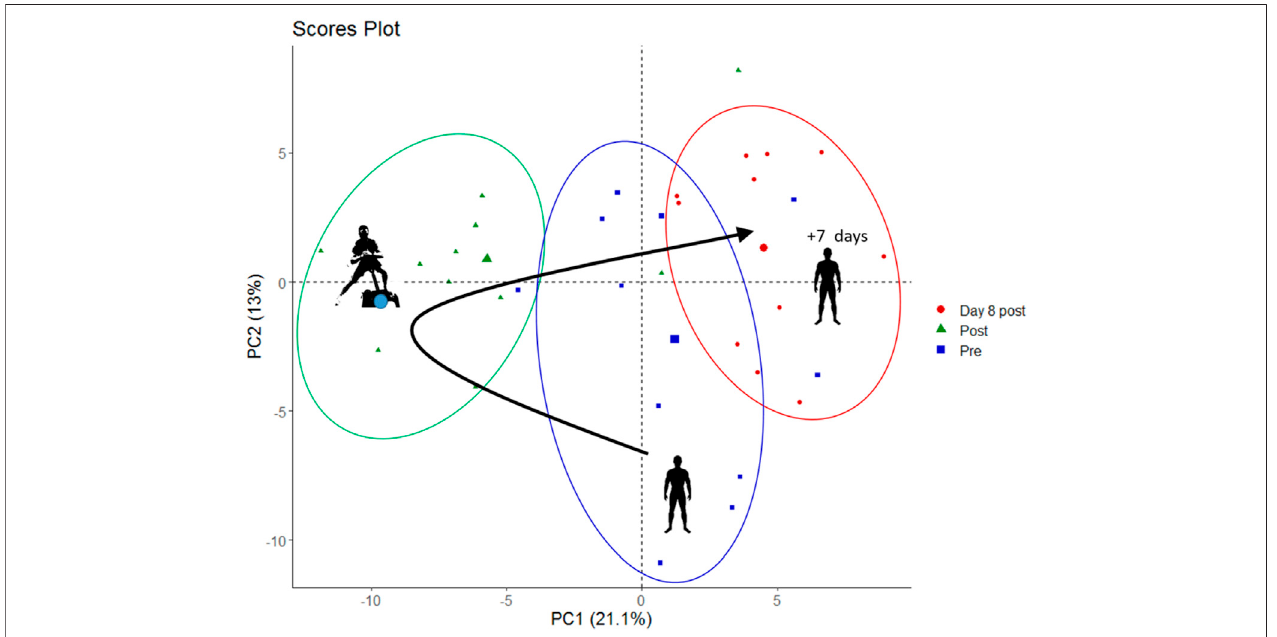
FIGURE 2 | PCA score plot showing metabolite data from pre-exercise, immediately post-exercise and on day 8 post exercise (marked as blue squares, green triangles, and red circles, respectively).